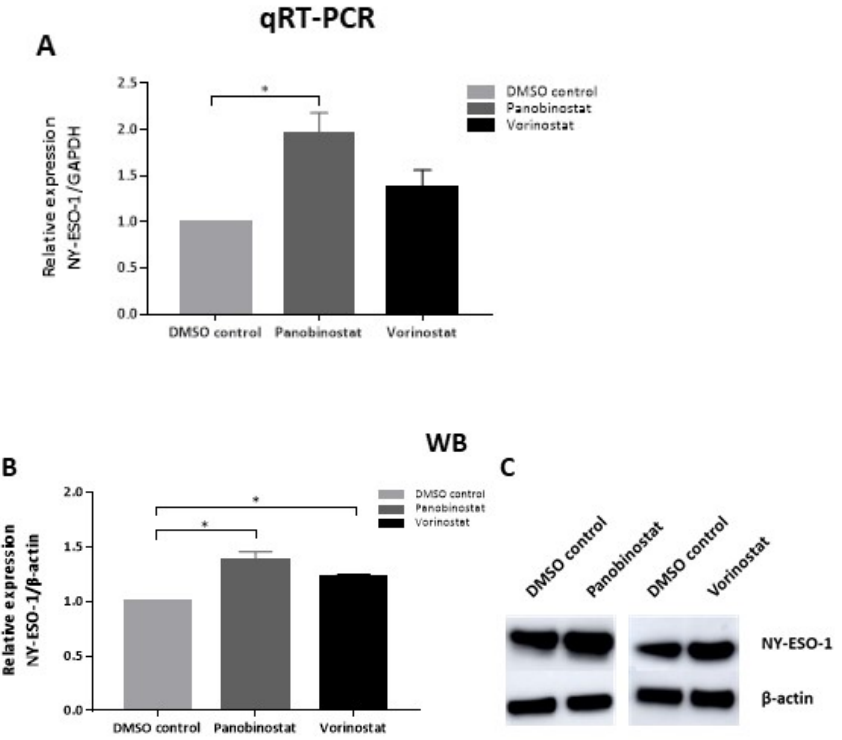
Figure 2. NY-ESO-1 expression in SW982 cells after treatment with panobinostat or vorinostat. SW982 cells were treated with 0.005 µ M panobinostat or 0.5 µ M vorinostat for 48 h, respectively. DMSO served as solvent control. The mRNA ( A ) and protein expression ( B ) of NY-ESO-1 were normalized to GAPDH and β -actin, respectively. Representative protein bands are displayed ( C ). Each column represents three individual experiments with three replicates. Statistical significance was calculated using one-way ANOVA. * p <